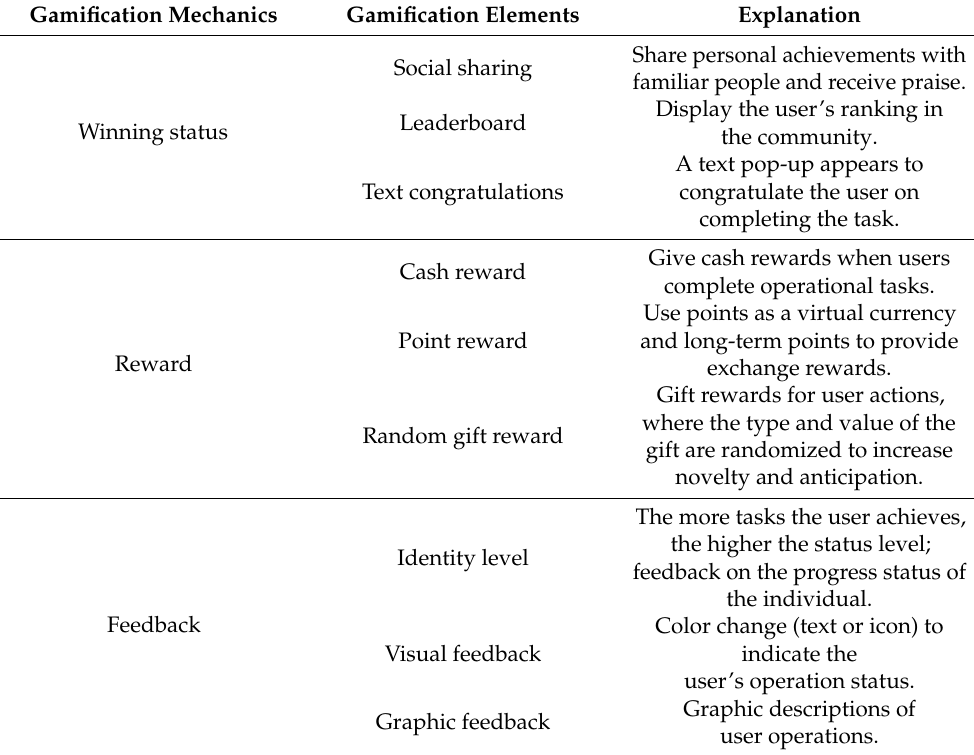
Table 3. Choose gamification elements for seniors.